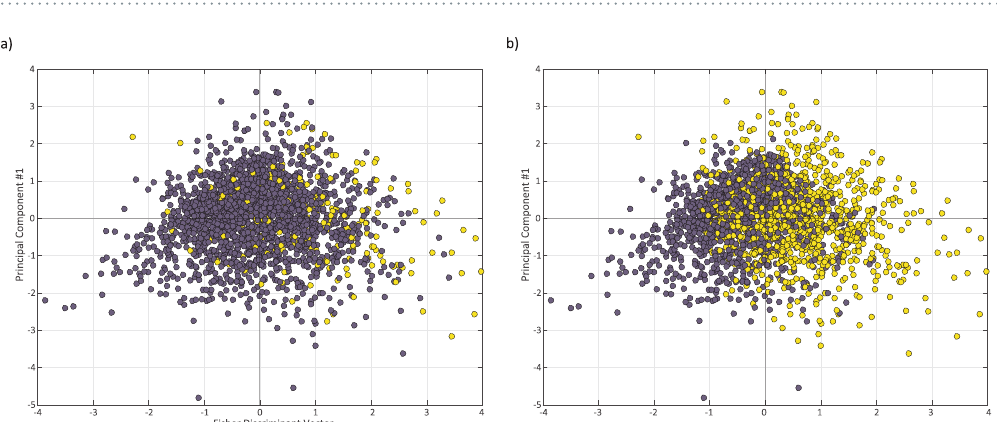
Figure 4. Fisher discriminant analysis over Dataset 1, treating all miRNA-, snoRNA- and TFBS-bearing patterns as functional, and the rest as non-functional. (a) A scatter plot of all unique patterns, yellow: function- bearing patterns, blue: function-lacking patterns. The x-axis is the Fisher discriminant vector, the y-axis is used for visualization only, and represents the first principal component orthogonal to the Fisher discriminant vector. (b) Recoloring of the same scatter according to model’s predictions. Yellow: predicted to be functional, blue: predicted to be